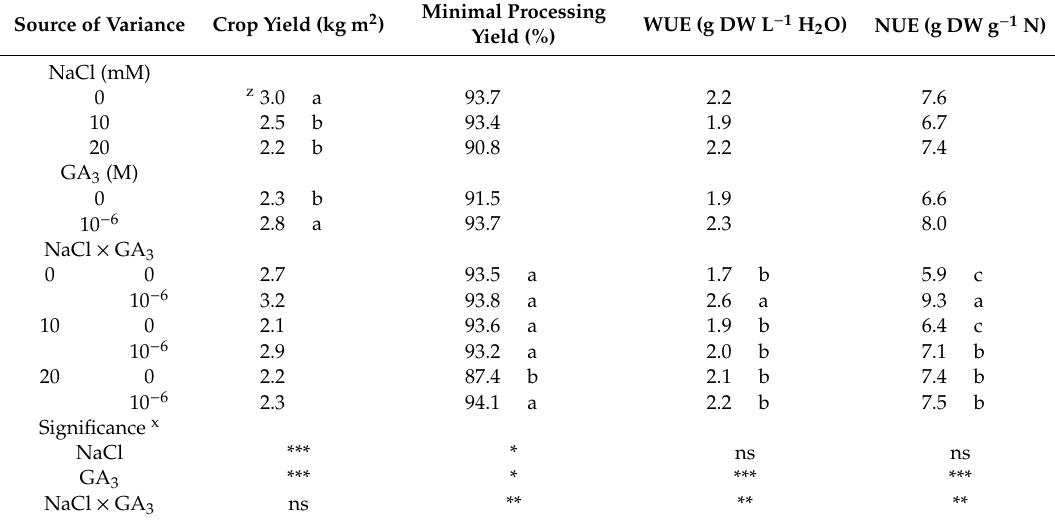
Table 6. Yield parameters of rocket plants grown in nutrient solutions containing di ff erent levels of NaCl and GA 3 . Source of Variance Crop Yield (kg m 2 )